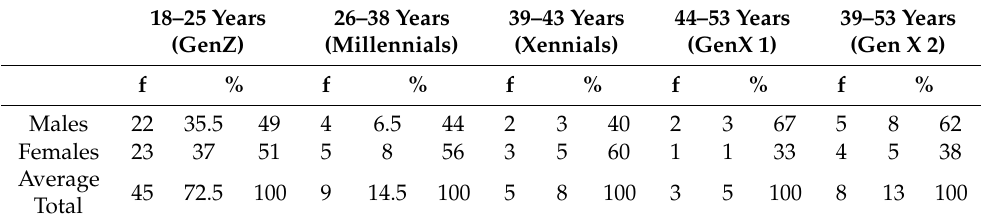
Table 1. Budding journalists’ demographics.